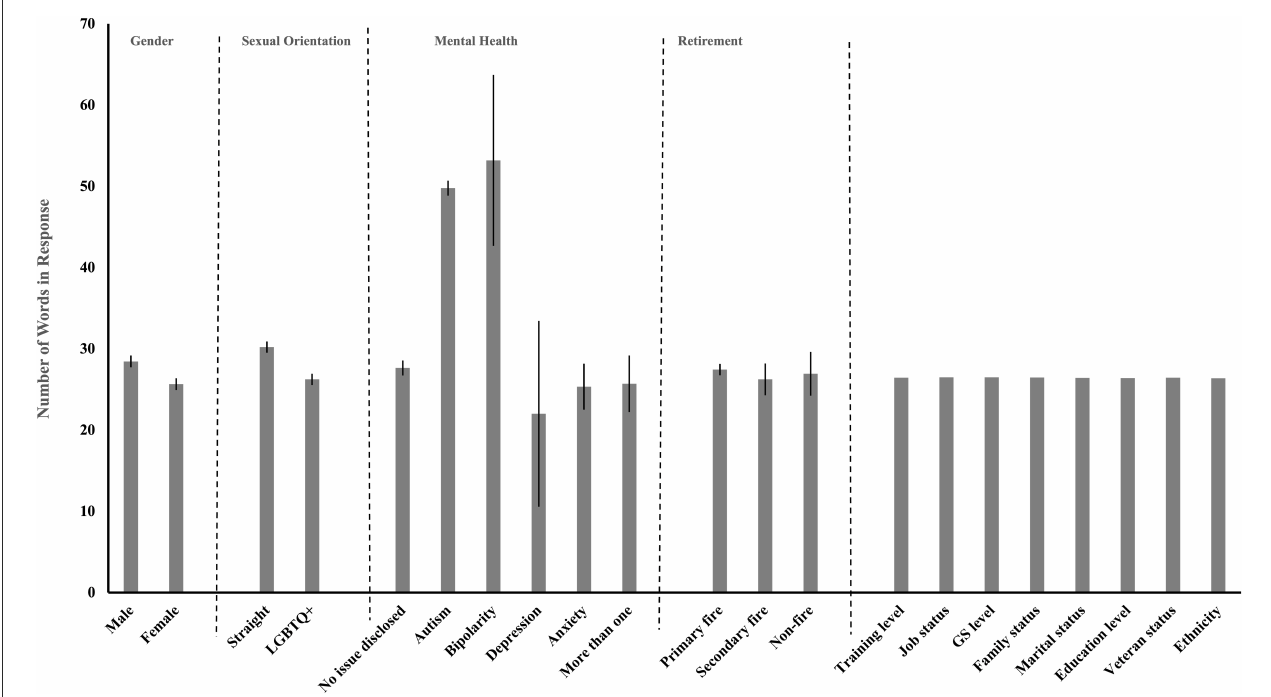
FIGURE1 Response length is significantly different between minority and majority groups within demographics. Mean = mean number of words written in a response. Alpha = 0.15. Gender P = 0.0005. Sexual Orientation P = 0.1444. Mental Health Status P = 0.0381. Retirement Status P = 0.0001. Bars represent standard error. Error bars are not presented for non-significant terms.